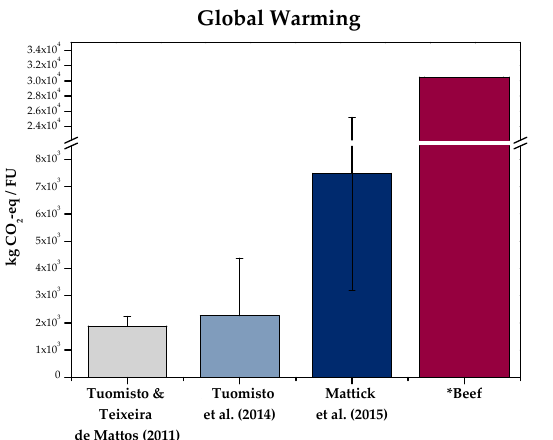
Figure 1. Global warming expressed in kg CO 2 -eq per 1000 kg of cultured meat, per study. *Beef reference was based on the results indicated by Mattick et al. (2015).